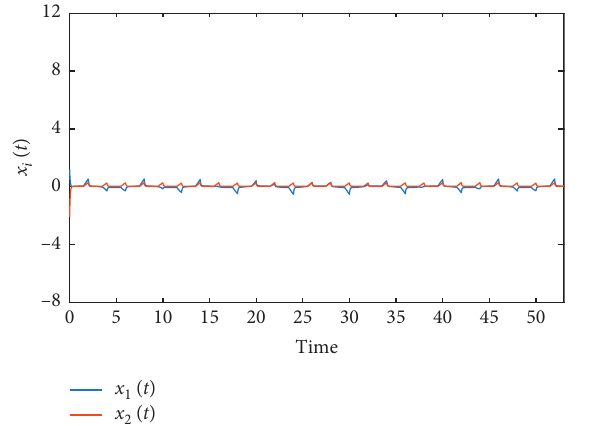
Figure 7: State trajectories x observer-based PIC.